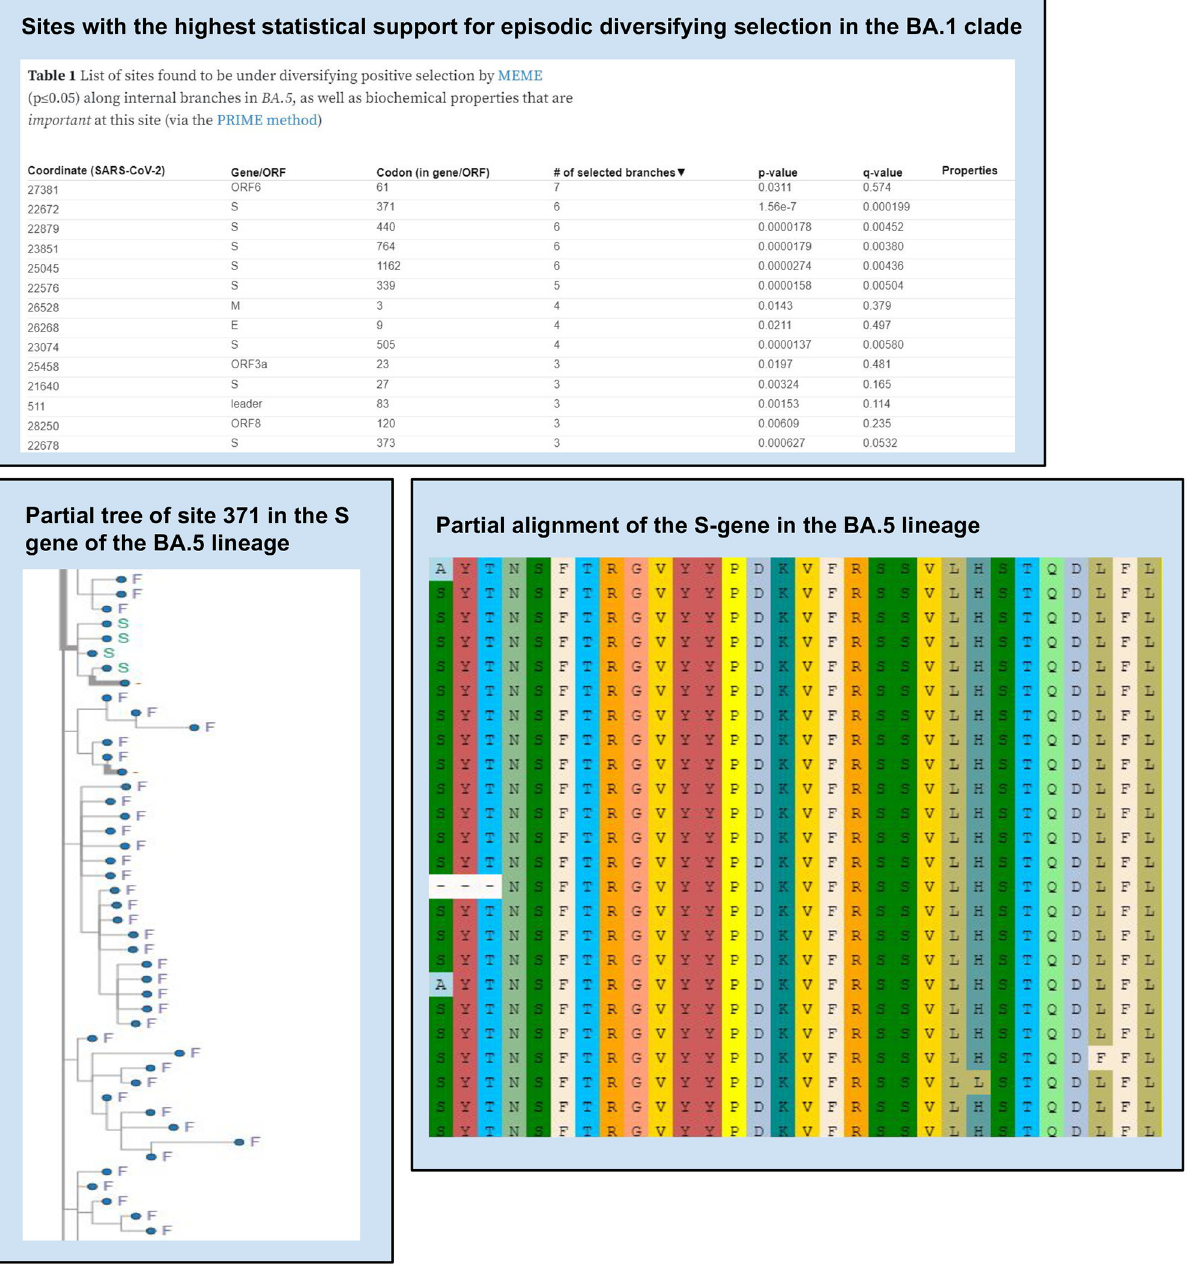
median (per gene) of 524 BA.1 sequences (a compression ratio of 99.53%) and a median of 145 background sequences (from a dataset of over 150,000 publicly available sequences from ViPR) to represent genomic diversity in SARS-CoV-2. Using the Spike gene as an exemplar, we compressed all available sequences down to 933 representative sequences, reflecting a